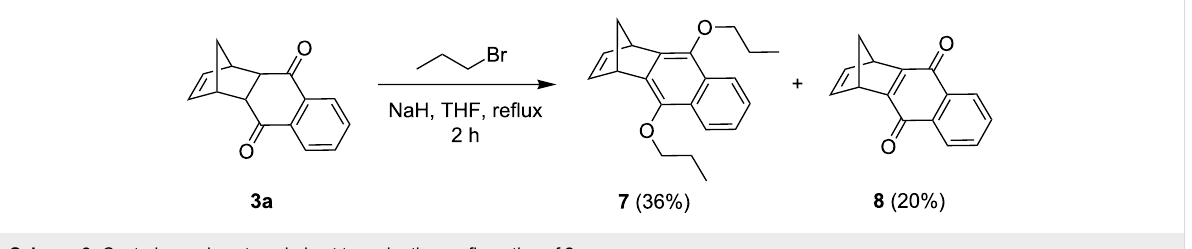
Scheme 3: Control experiment carried out to probe the configuration of 2a .